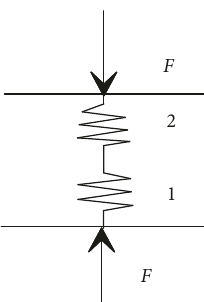
Figure 1: Stiffness of the series system between hard coal gangue and top coal. (1) Top coal stiffness K m . (2) Hard layer coal gangue stiffness K c